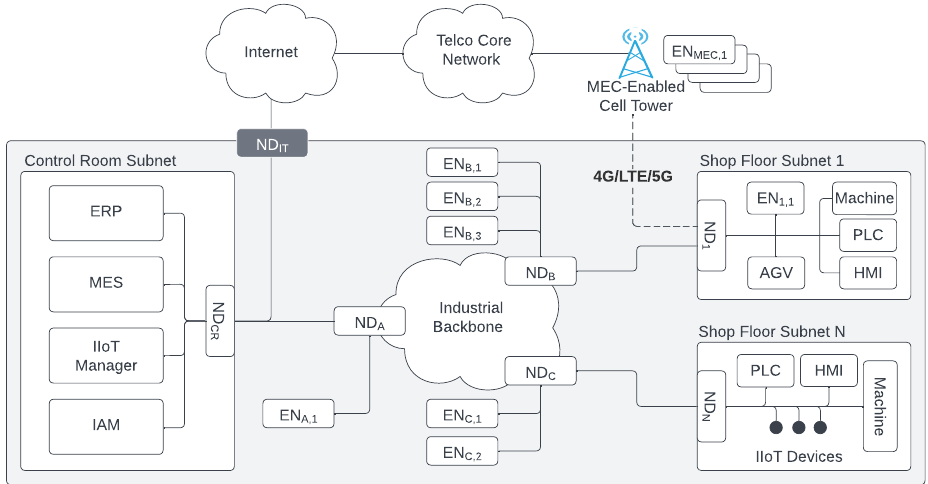
Figure 1. A MEC-integrated industrial environment. The industrial boundaries, depicted in light gray, include control room and shop floor subnets interconnected by the industrial backbone. MEC resources are outside the industrial boundaries, possibly available over cellular links at the shop floor